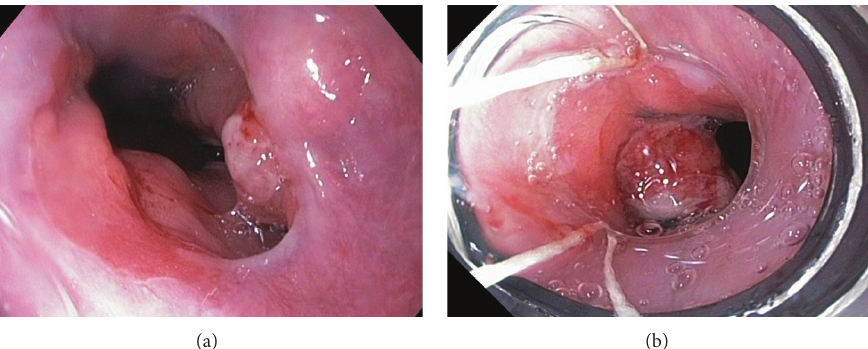
Figure 1: (a) Esophagus: a tongue of Barrett’s was found in the distal third of the esophagus. (b): A nodule was found in the GE junction. A mucosal resection (using a Duette EMR kit) was performed, with success.